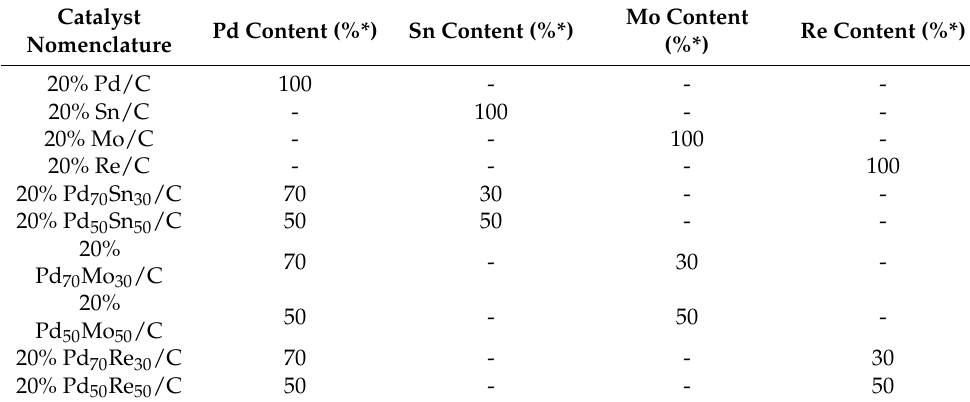
Table 3. Nominal catalysts metal composition and